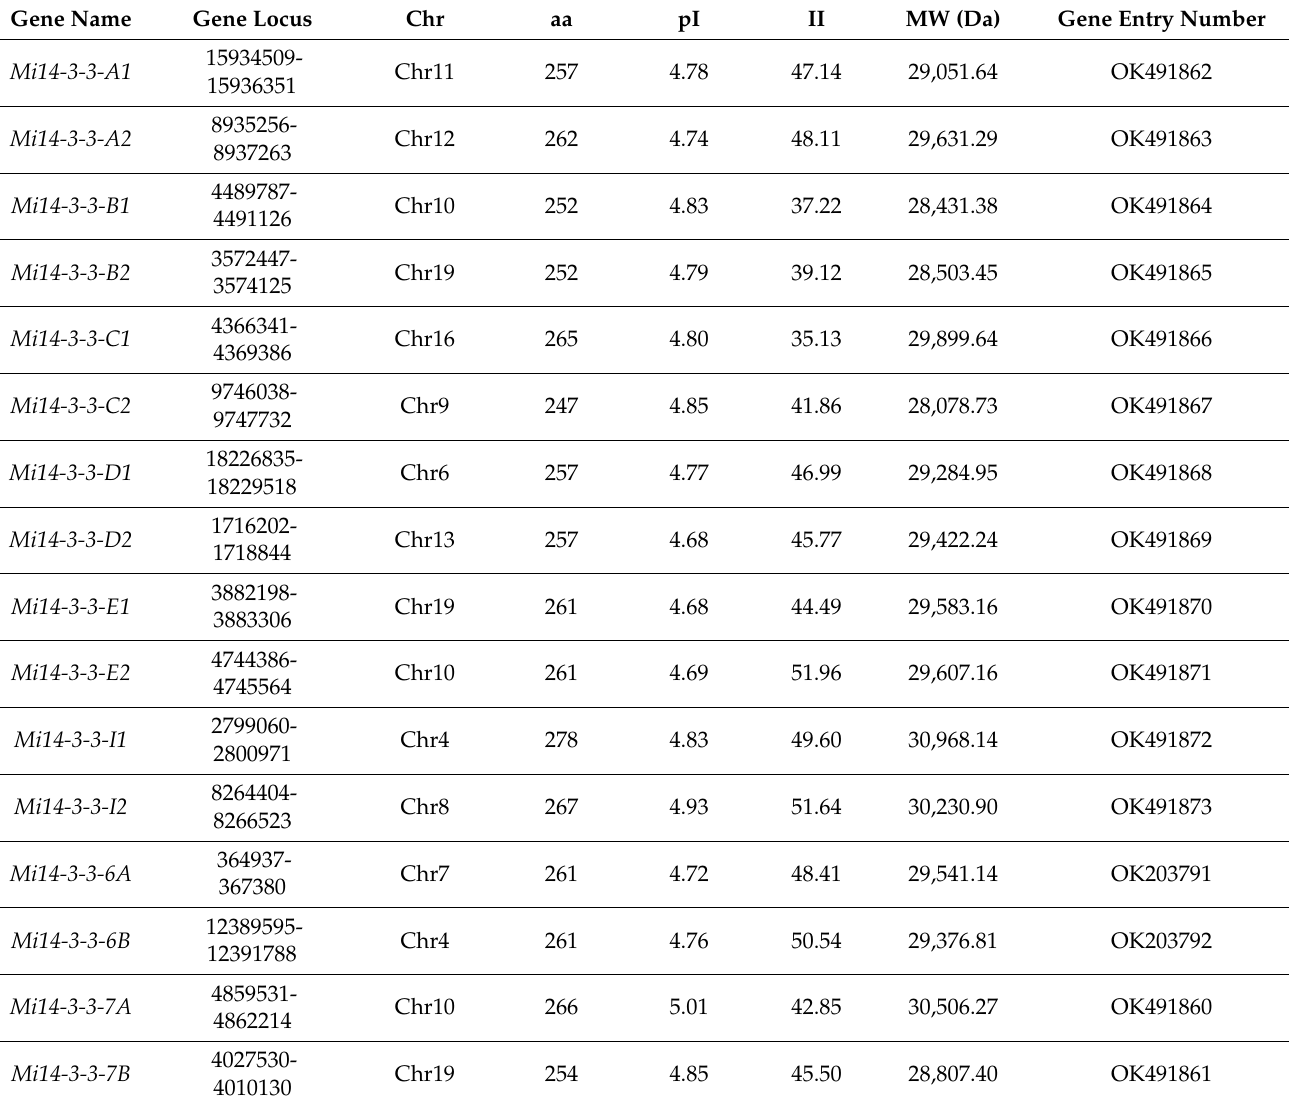
Table 1. Information concerning 14-3-3 genes in